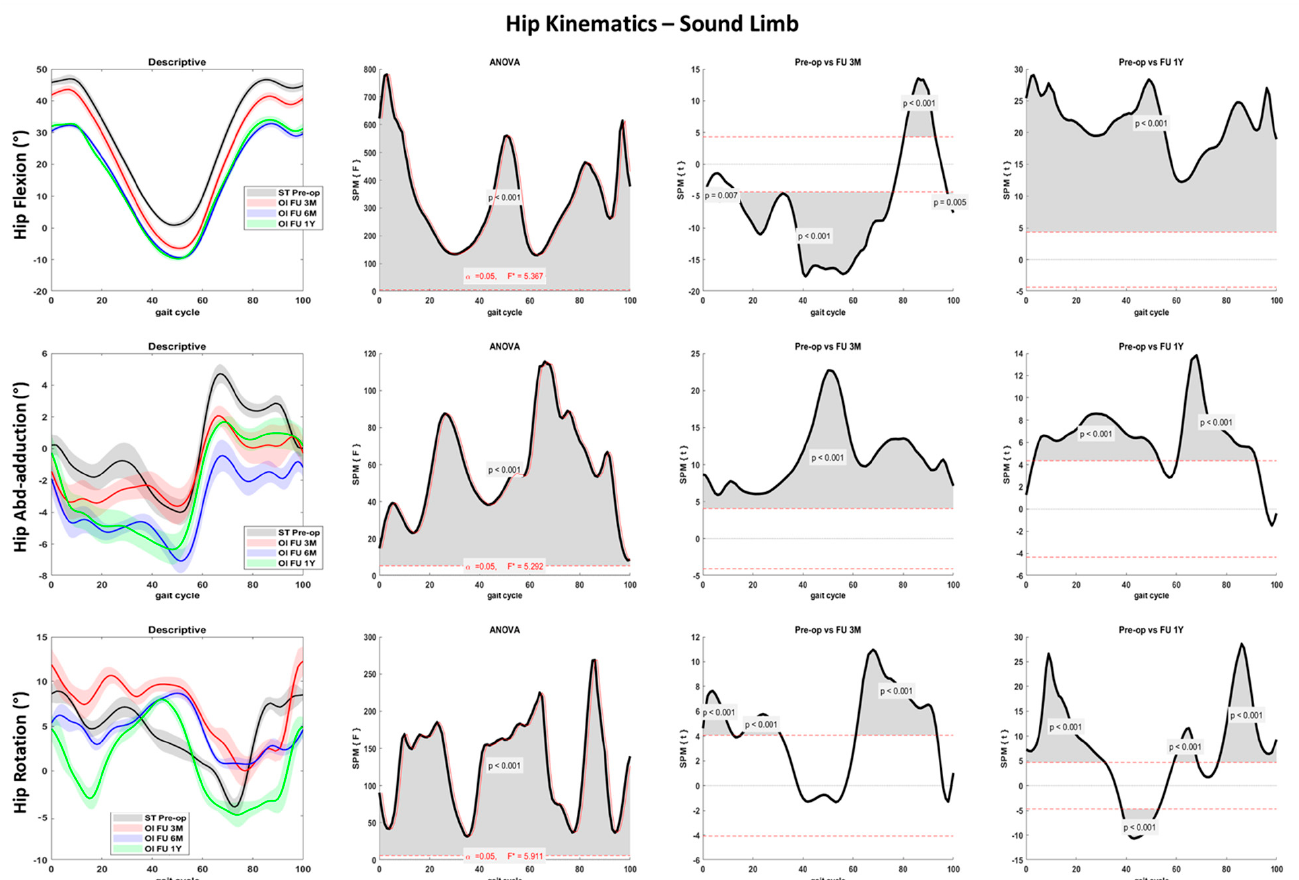
Figure 5. Hip joint kinematics for the sound limb over the percentage of the gait cycle for the fast gait in sagittal (first row), frontal (second row), and transverse (third row) planes. Descriptive data (first column) are expressed as mean (solid line) and standard deviation (dashed line). The gray line represents pre-operative gait analysis with socket-type prosthesis (ST pre-op), the red line represents gait analysis at 3 months follow-up with osseointegrated prosthesis (OI FU 3M), the blue line represents gait analysis at 6 months follow-up with osseointegrated prosthesis (OI FU 6M), the green line represents gait analysis at 1-year follow-up with osseointegrated prosthesis (OI FU 1Y). The results of the spm1D repeated-measure ANOVA are presented in the second column. Gray areas represent statistically significant differences ( p < 0.05) among the groups. The differences between pre-operative phase and either 3 months follow-up (third column) or 1-year follow-up (fourth column) were assessed through t-test with Bonferroni correction. Table 4. Descriptive peak hip joint kinematics for the amputee and sound limb in the pre-operative gait analysis (socket-type prosthesis, ST) and the follow-up gait analyses (osseointegrated prosthesis, OI). Data are presented for the fast gait as mean ± standard deviation separately for stance and swing phases.